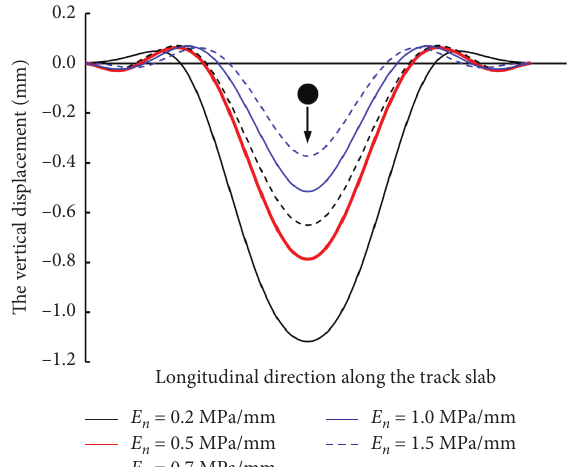
Figure 26: Maximum compression deformation of the selected side for various E